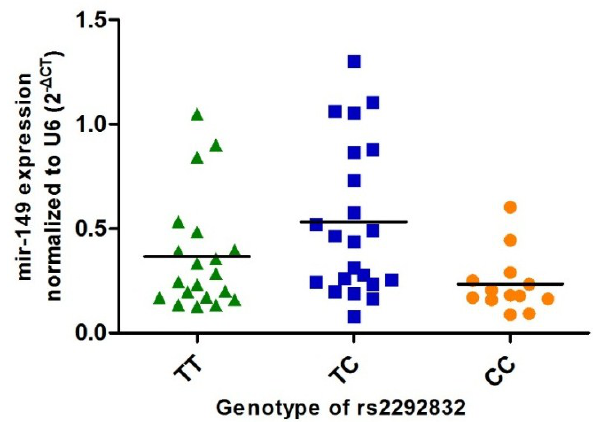
Figure 1. Association between rs2292832 genotype and expression level of mir-149-5p